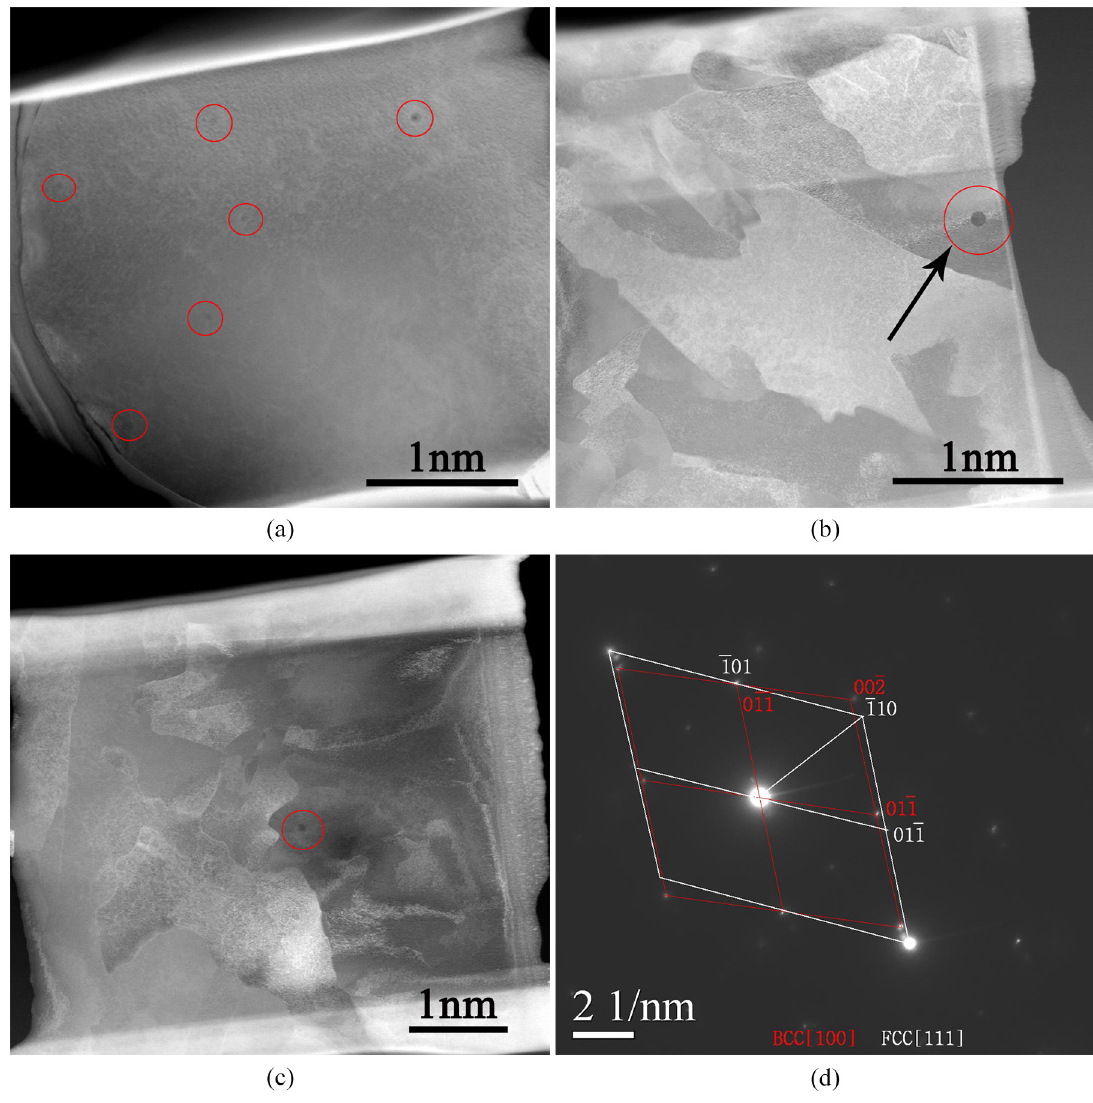
Figure 5. The TEM image of cross sections of Fe-1.3Mn alloy powders with size of (a) 4µm, (b) 75µm, (c) 170µm, (d) The SAED pattern of precipitated phases.